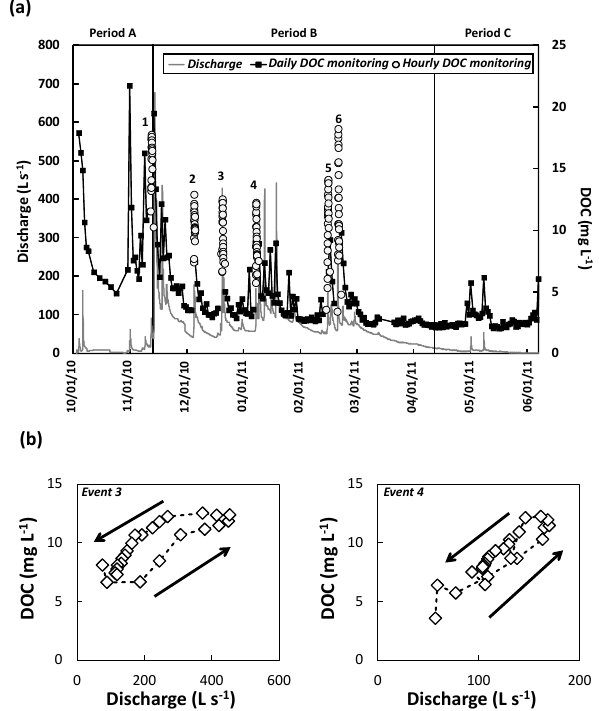
Figure 4. (a) Temporal variations in stream discharge and DOC concentrations at the catchment outlet during the study period and (b) example of DOC concentrations versus discharge showing hysteresis patterns (arrows indicate chronology). Monitored storm events are indicated by numbers in box (a)